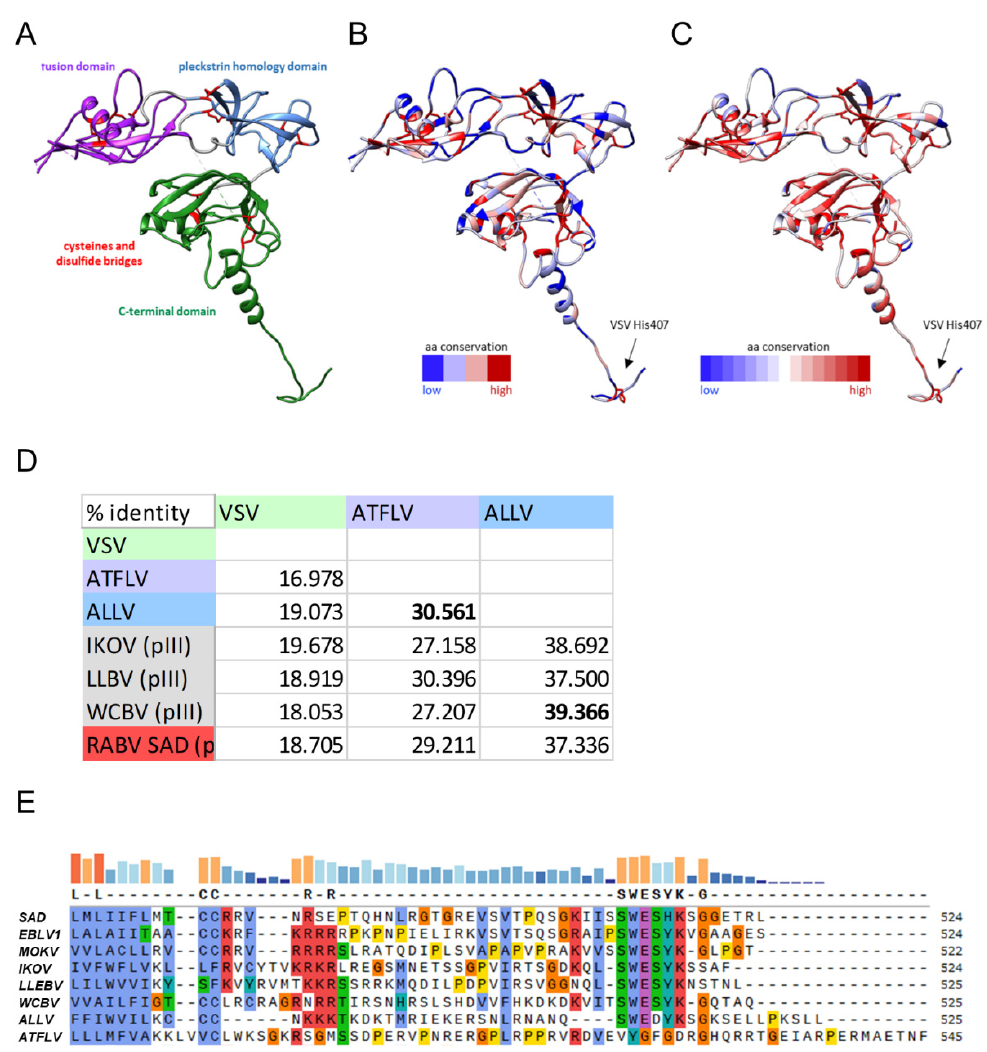
Figure 1. Analysis of G protein sequences. ( A – C ) Domain organization and sequence conservation of lyssavirus G proteins. ( A ) Structure of the RABV G protein (pdb: 6LGX) with the structural domains and cysteine residues highlighted. ( B ) Degree of sequence conservation per residue when comparing RABV, MOKV, ALLV, and ATFLV. ( C ) Degree of sequence conservation per residue when comparing the G protein sequences of all known lyssavirus species. The conserved histidine at position 407 of the VSV G protein is highlighted in B and C. The figure was generated with UCSF Chimera. ( D ) Comparison of